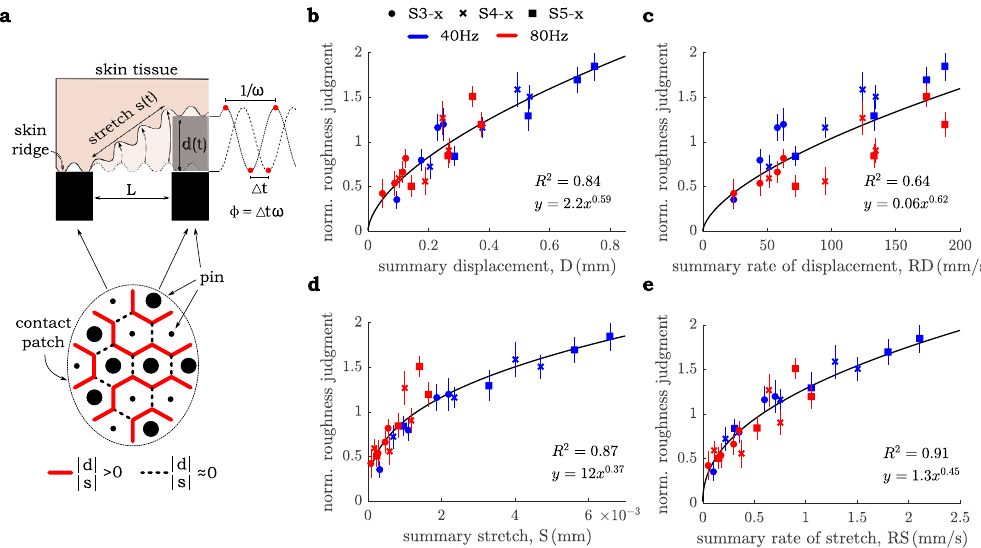
Figure 4. The mechanics model and the associated summary predictors. ( a ) Vertical pin positions within the fingerpad in the S5-x, x = 180° pin configuration. Sizes of solid circles within the contact patch correspond to the vertical pin position, as demonstrated by a side view of skin indentation profile (not drawn to scale). Lines separating each pair of neighboring pins represent relative tissue displacement: near zero for pins of the same phase, and above zero for pins of differing phase. ( b – e ) Average roughness judgments (error bars represent standard error of the mean) plotted against the time-average of summarized absolute predictors, as follows: ( b ) Displacement from Eq. (1); ( c ) Rate of displacement from Eq. (2); ( d ) Stretch from Eq. (4); ( e ) Rate of stretch from Eq.